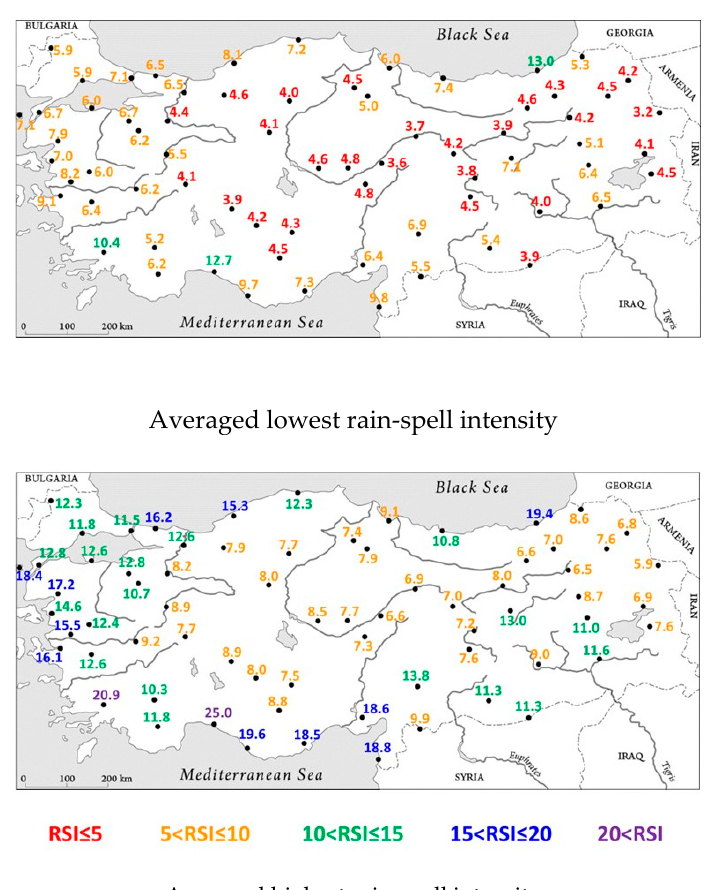
Figure 9. Mean annual rain-spell intensity (RSI) in Turkey (1970–2011).